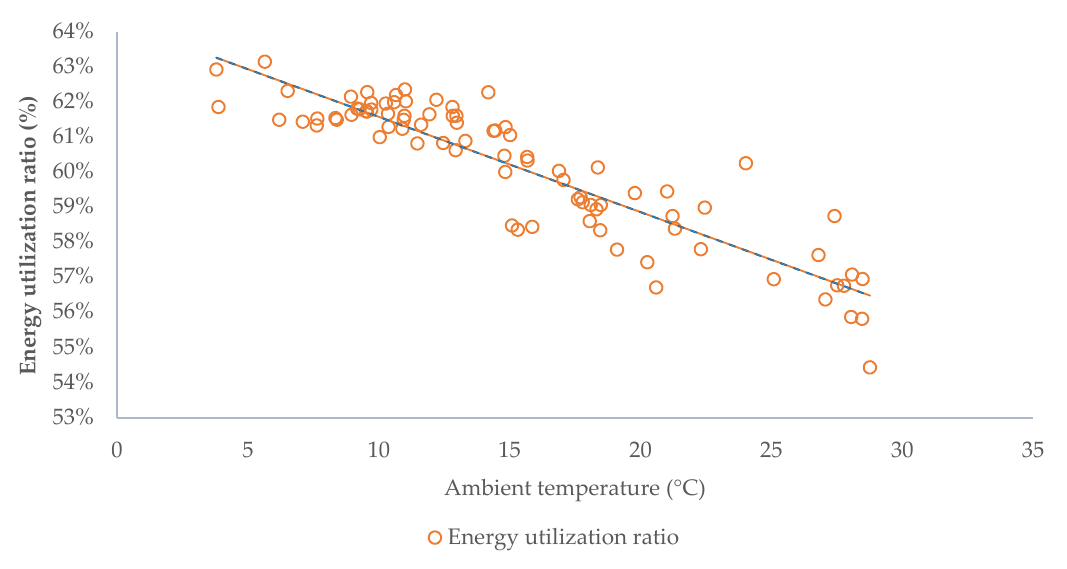
Figure 14. Collector energy utilization ratio.